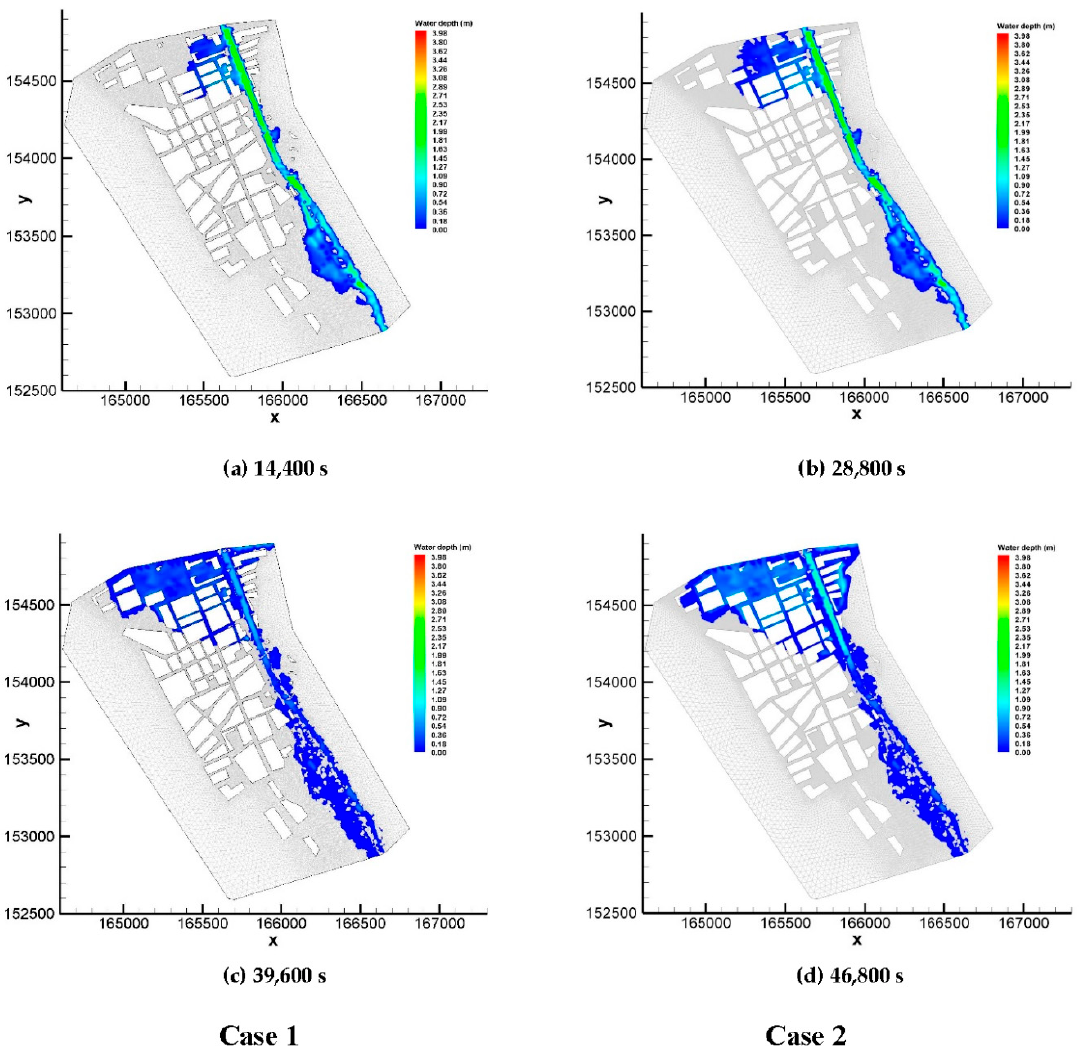
Figure 8. Comparison of spatial distributions of inundated water depth with time for Case 1 and 2.